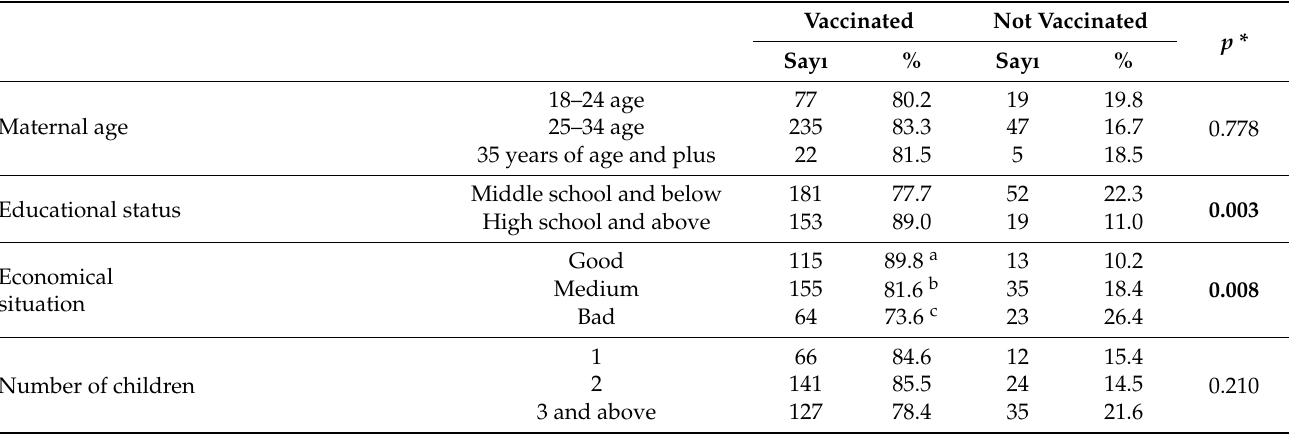
Table 3. COVID-19 virus vaccination status of the mothers participating in the study according to some descriptive